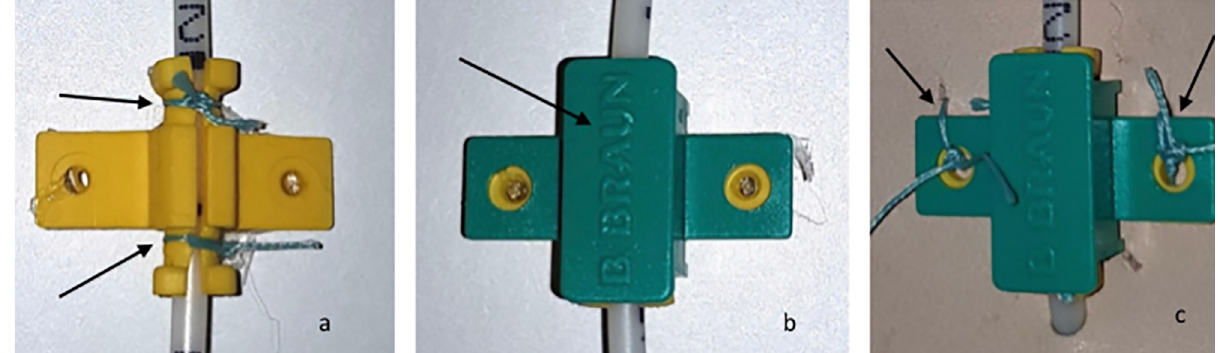
Fig 2. Steps of the “compression” technique. A) Two sutures are placed at the inner soft part of the clamp to increase compression of the soft part and to increase friction between the soft part of the clamp and the catheter. B) The outer rigid part of the clamp is placed on top of the soft part. C) The clamp is sutured to the